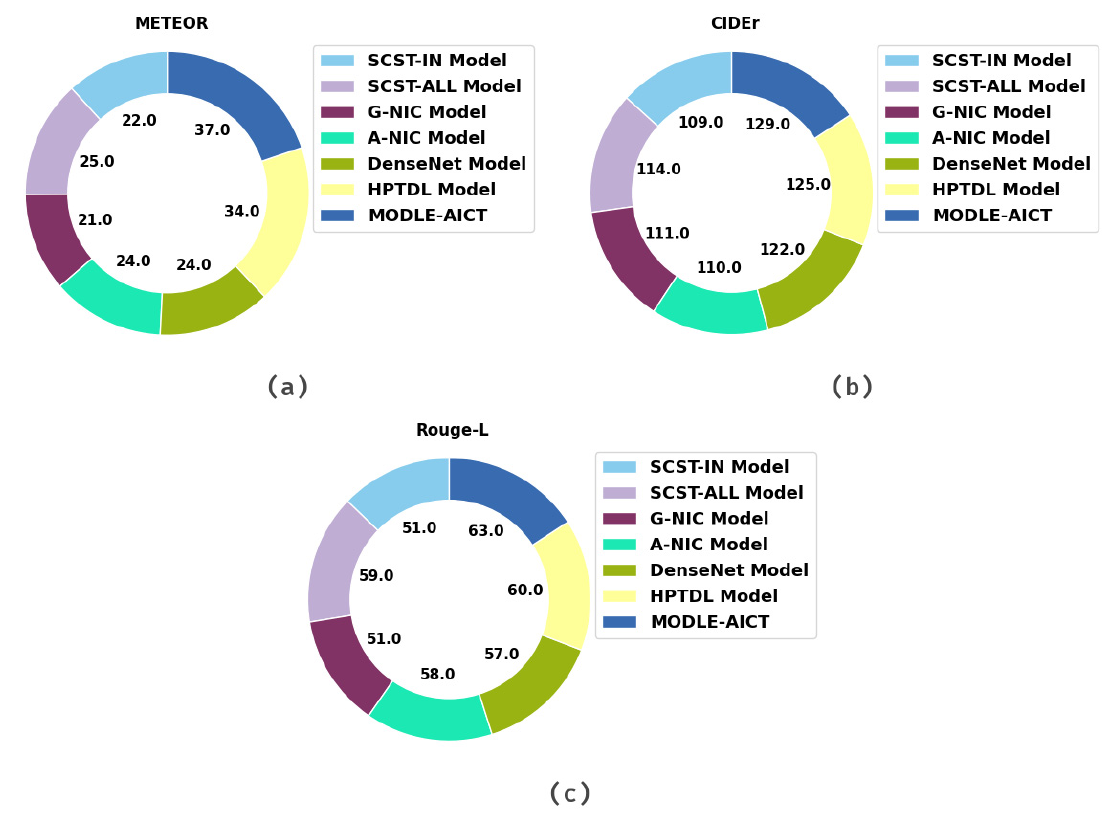
Figure 9. Result analysis of MODLE-AICT algorithm on MS-COCO 2014 dataset ( a ) METEOR, ( b ) CIDEr, and ( c ) Rouge-L. Table 5. Classification analysis of MODLE-AICT algorithm with approaches to MS-COCO 2014 da- taset.